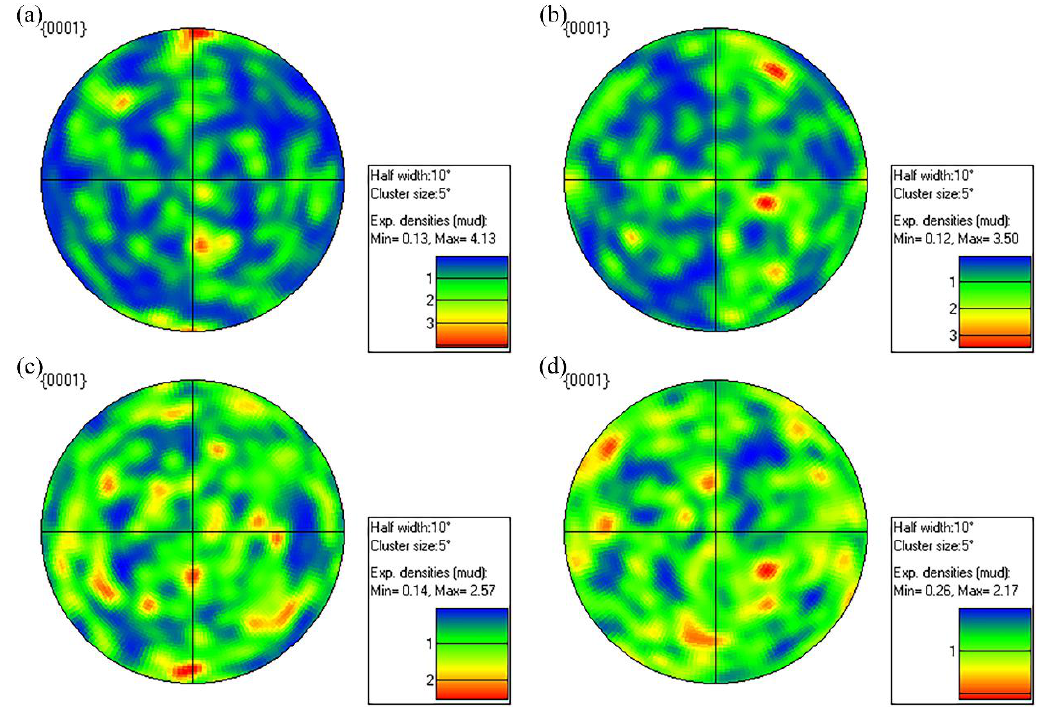
Figure 7. Electron back scatter diffraction (EBSD) pole figures of Mg–7Gd–5Y– x Zn–0.5Zr alloys: ( a ) x = 0 wt%; ( b ) x = 3 wt%; ( c ) x = 5 wt%; ( d ) x = 7 wt%.